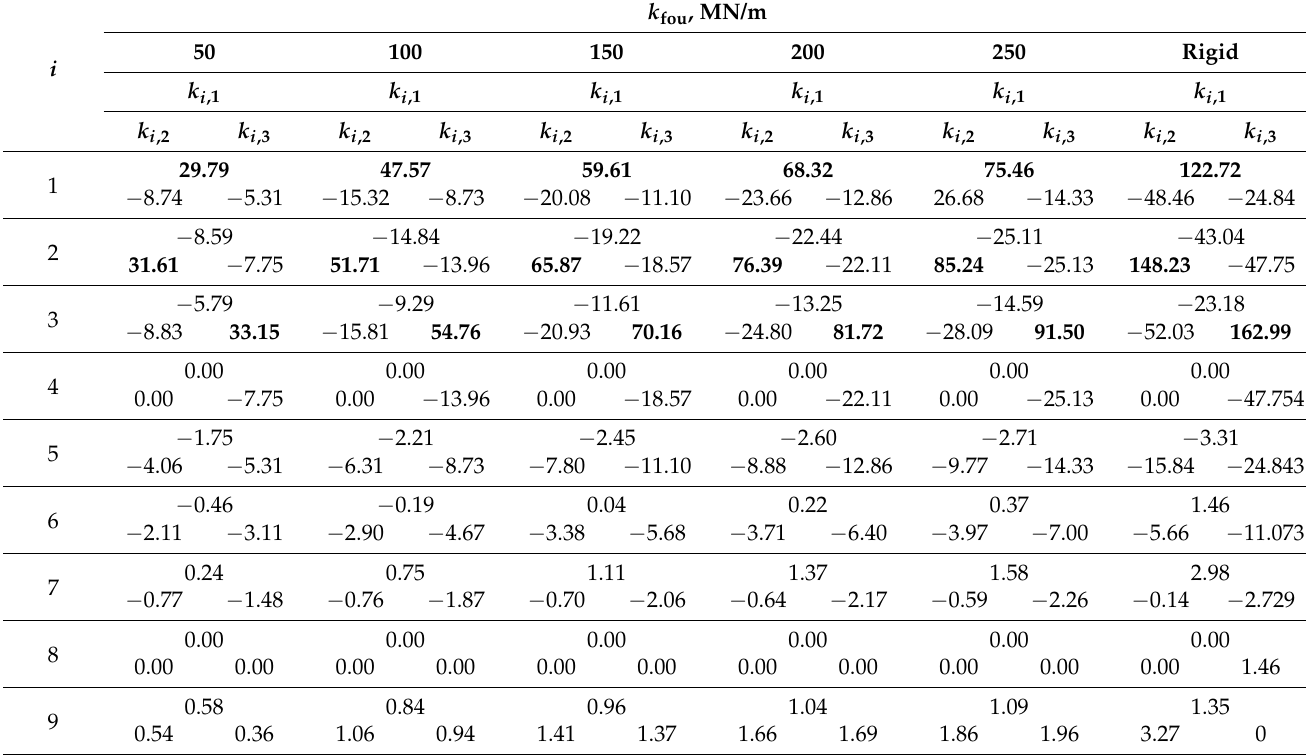
Table A7. Values k i , j of stiffness matrix k expressed in MN/m, for n = 32 and k fou = 50, 100, 150, 200, 250 MN/m and k fou - rigid (elements k j,j ( i = j ) are given in bold).